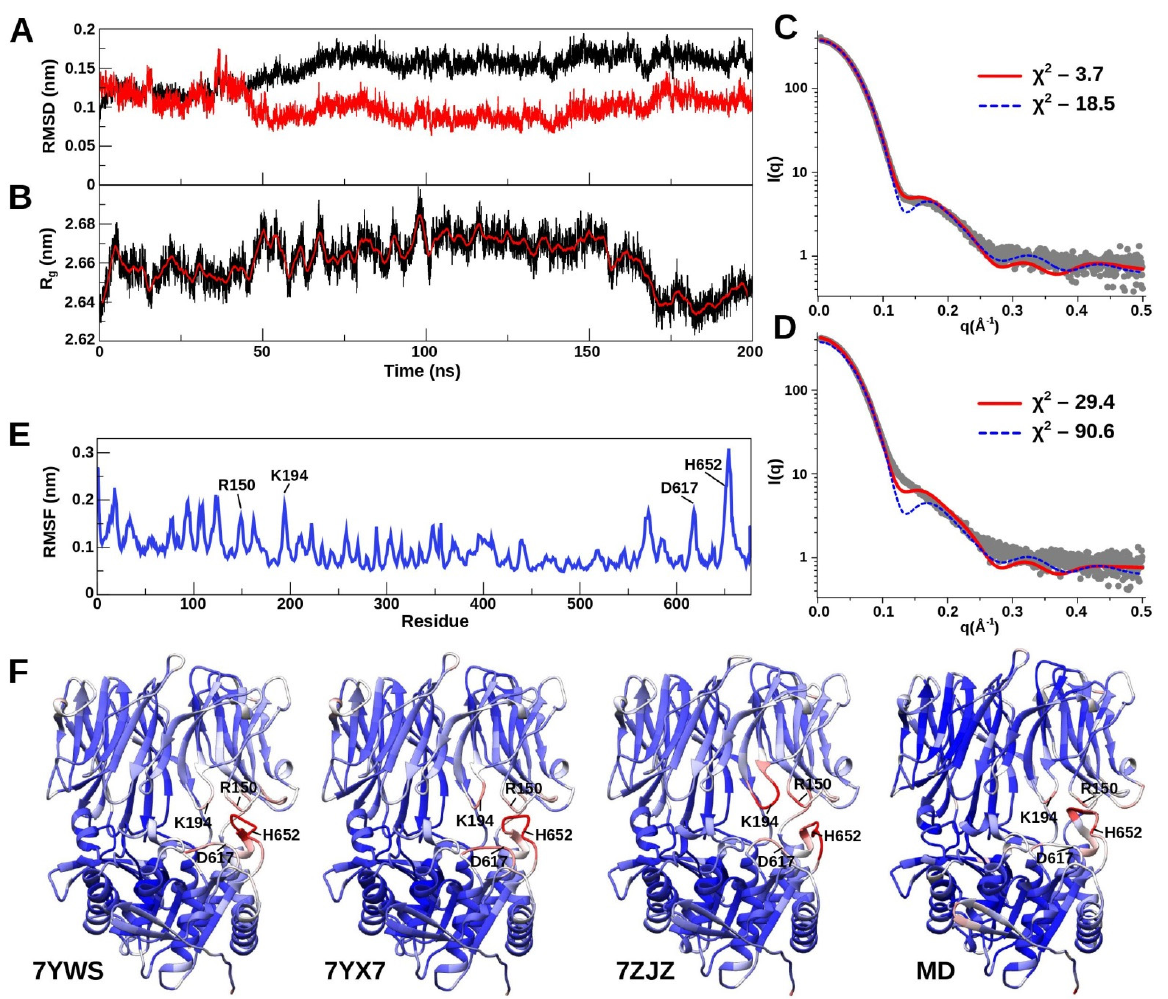
Figure 5. Comparison of the results of the 200 ns MD simulation of SpOPB with the SAXS data and the crystal structures of SpOPBmod and SpOPBS532A. The SpOPBS532A structure with the recovered S532 was used for modeling. ( A ) The standard deviation of the main chain atoms on the MD trajectory (the black line is the RMSD relative to the initial structure, and the red line is the RMSD relative to the average structure). ( B ) The change in the radius of gyration (R g ) (the red line is the average of 100 frames). ( C ) The experimental SAXS profile of SpOPB in the presence of spermine (gray dots) fitted to the theoretical curves for the averaged structures from the MD simulation (red solid line) and the SpOPBS532A crystal structure (blue dashed line). ( D ) A similar overlay of the theoretical curves on the experimental SAXS profile obtained for the free SpOPB (gray dots). ( E ) Per residue RMSF for the entire MD trajectory and the mobilities of the key residues are correlated with the enhanced B ‐ factors from the crystal structures. ( F ) The crystal structures of SpOPBmod and SpOPBS532A, colored by the B ‐ factors, and the averaged structure from the MD simulation, colored by RMSF. Red means the maximum values, blue means the minimum values.